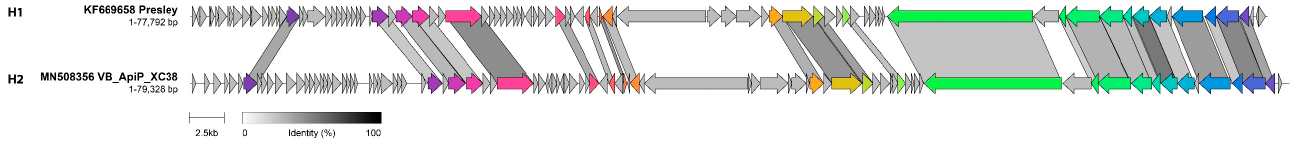
Figure 12. Comparative genome alignment of Acinetobacter phages classified within the family Schitoviridae . Phage genomes are presented alongside their designated sub-cluster, accession number, name and genome length. Coding sequences are represented by arrows, coloured to reflect homologous groups identified by Clinker, and are linked by grey bars shaded to represent the percentage amino acid identity, as indicated in the legend.